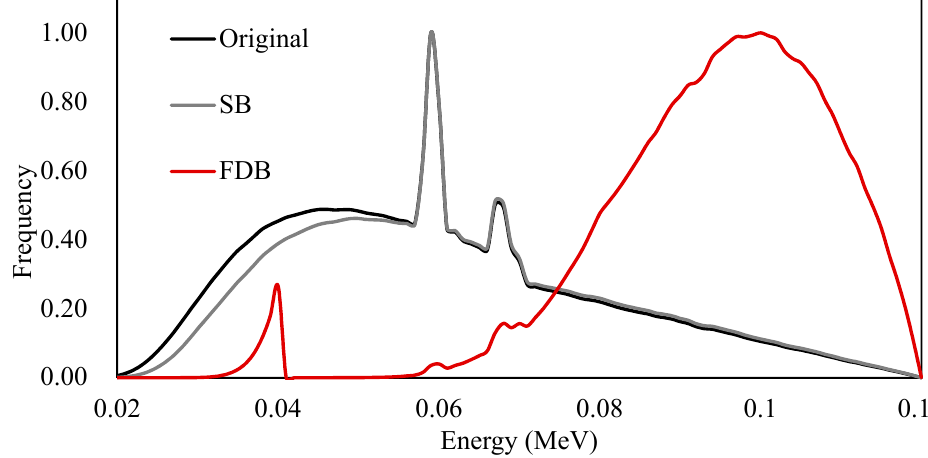
Figure 4. X-ray energy spectra adding different bowties at a tube voltage of 120 kVp.